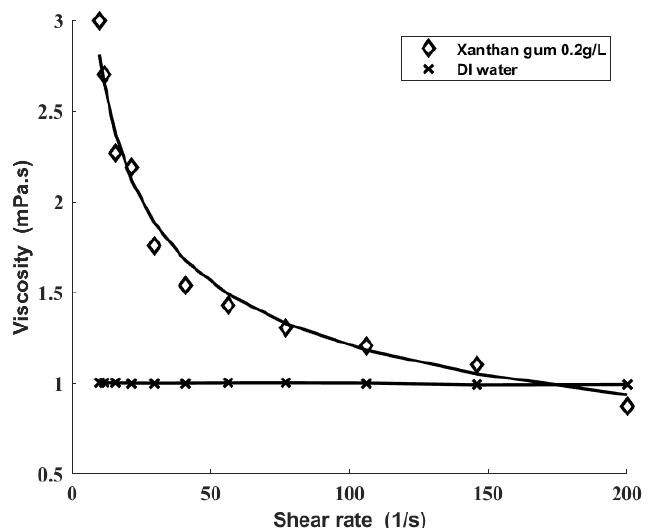
Figure 5. Viscosities of xanthan gum solution and DI water. The measured values are marked by symbols. The fitting curves are marked by solid lines.